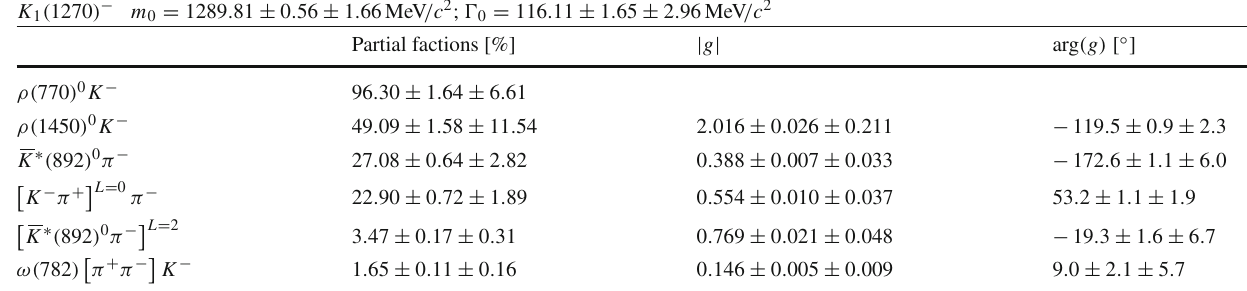
Table 4 Table of fit fractions and coupling parameters for the compo- nent involving the K 1 ( 1270 ) − meson, from the fit performed on the RS decay D 0 → K − π + π + π − . The coupling parameters are defined with